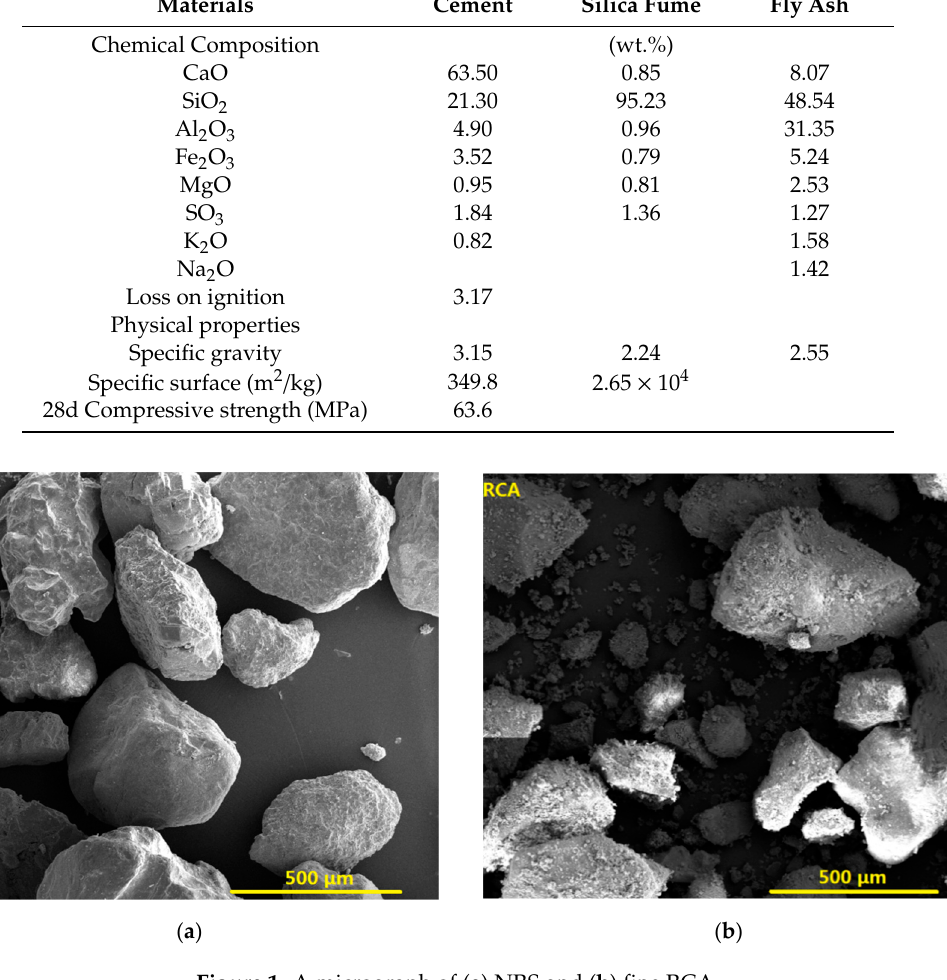
Figure 1. A micrograph of ( a ) NRS and ( b ) fine RCA.